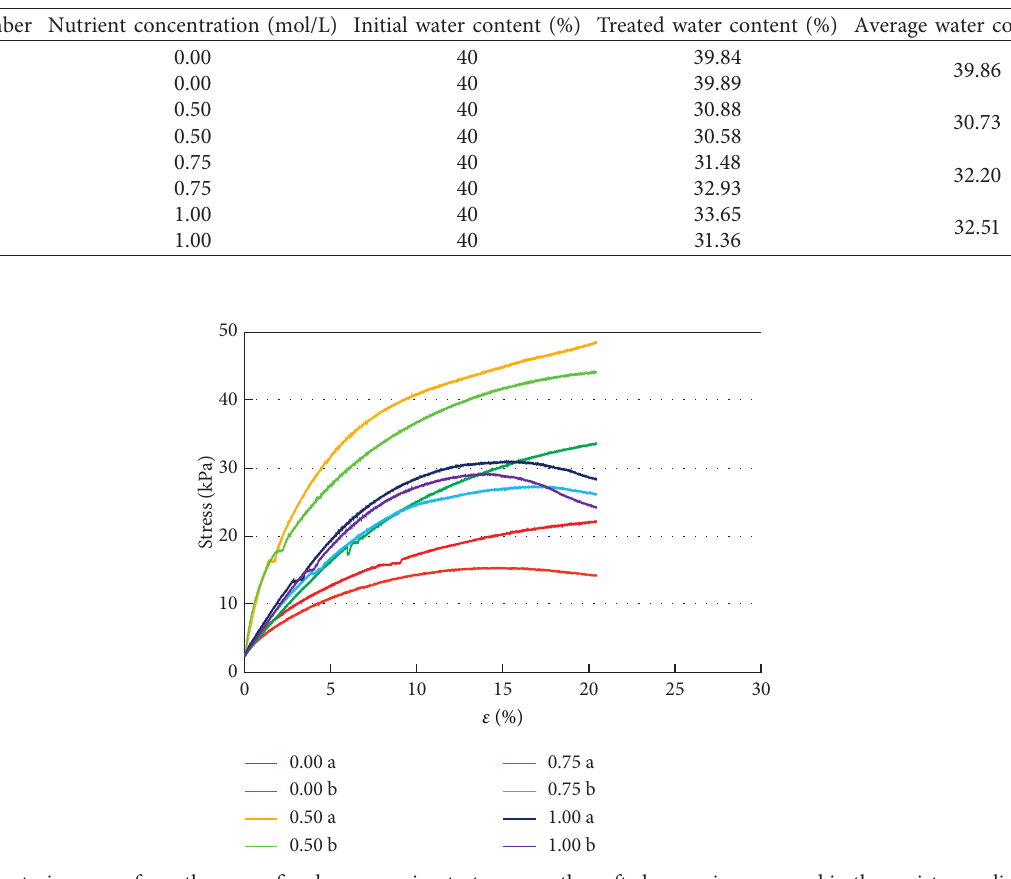
Table 4: Changes in soft clay specimen water content after curing for 28 days.